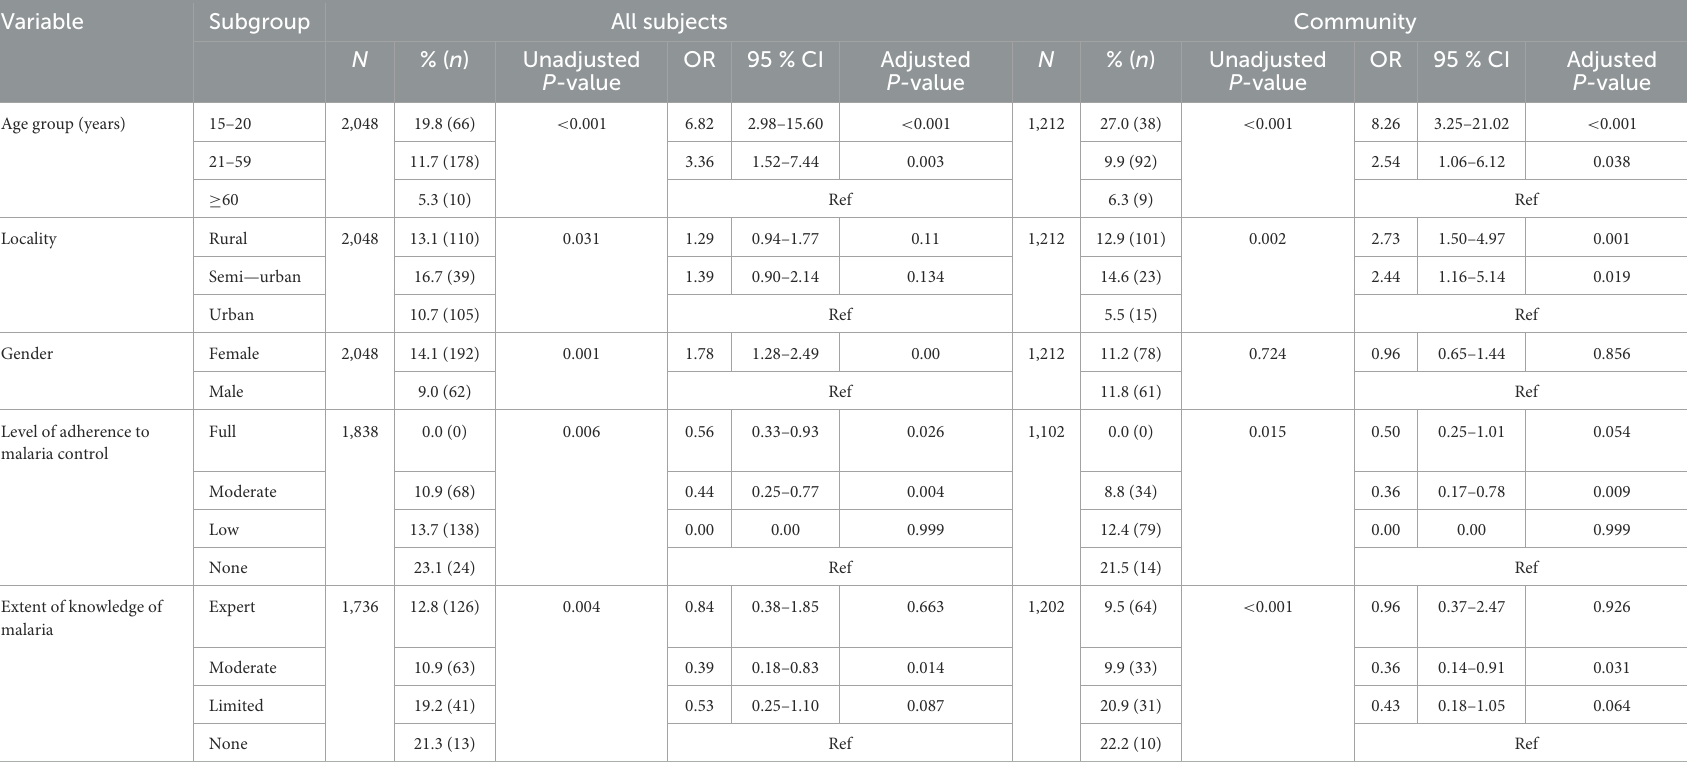
TABLE 6A Relationship between socio-demographic factors, adherence to malaria control, knowledge of malaria and asymptomatic malaria parasitaemia in Cameroon.